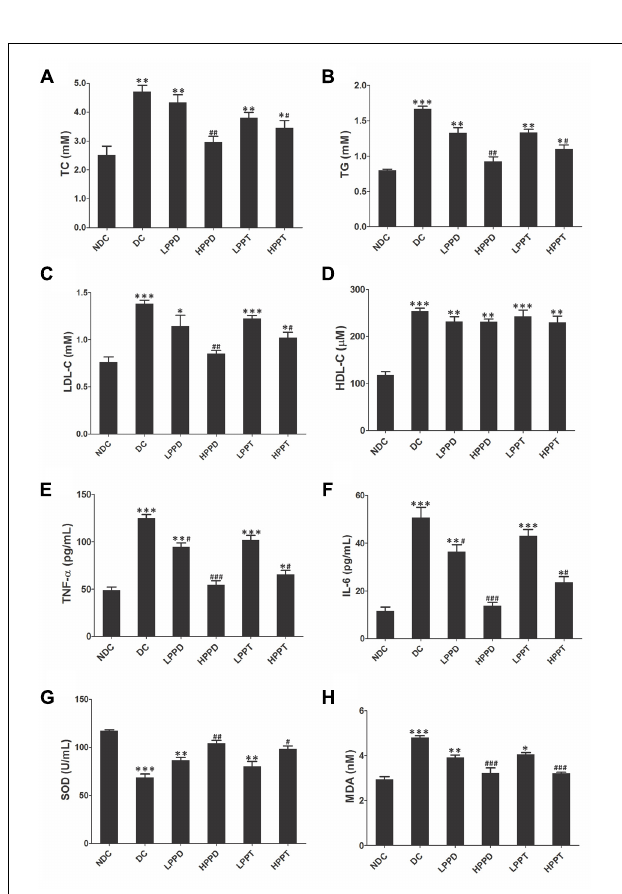
FIGURE 6 | PPD and PPT ameliorates lipid disorders in high-fat diet and STZ-induced diabetic mice. (A) TC, (B) TG, (C) LDL-C, (D) HDL-C, (E) TNF- α , (F) IL-6, (G) SOD, (H) MDA. ∗ p < 0.05, ∗∗ p < 0.01, ∗∗∗ p < 0.001 vs. NDC group, # p < 0.05, ## p < 0.01, ### p < 0.001 vs. DC group. Different groups were significantly different ( p <